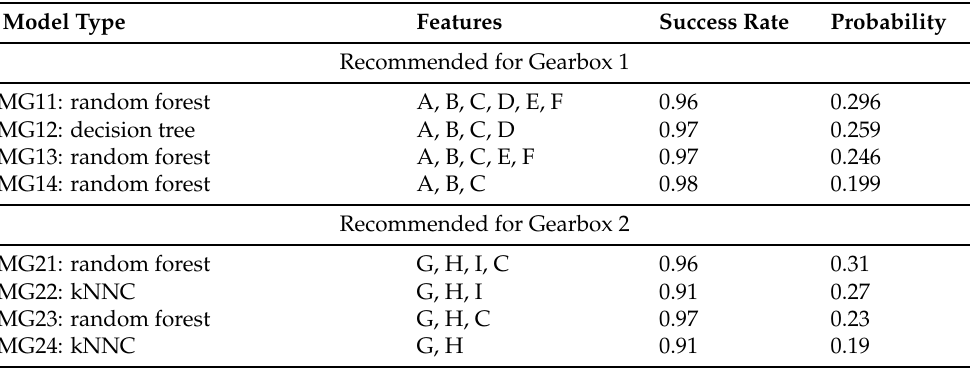
Table 6. Models recommended for Gearbox 1 and Gearbox